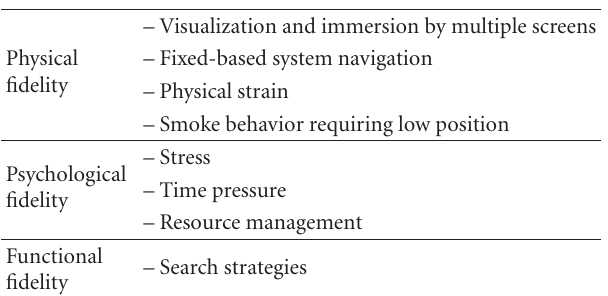
Table 3: Fidelity of SIDH